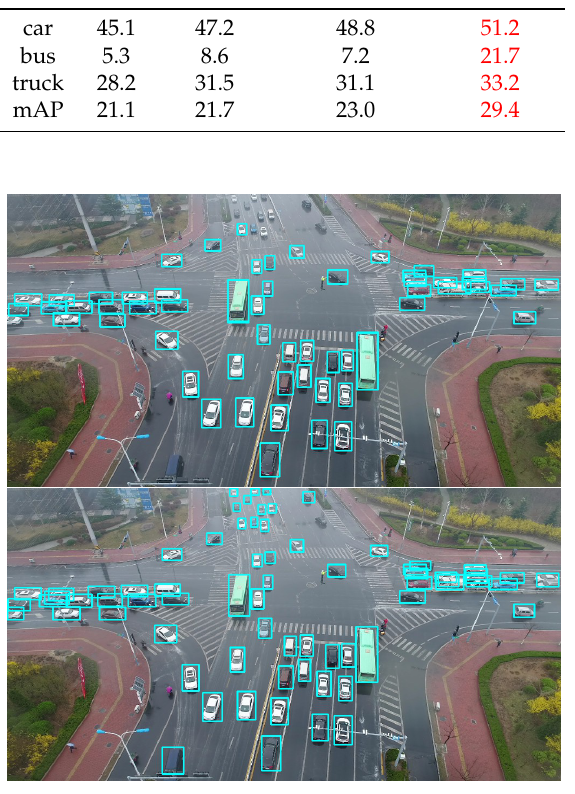
Figure 11. Selected visual comparison of DOTA benchmark dataset which includes Libra RCNN on the top and MB-RPN on the